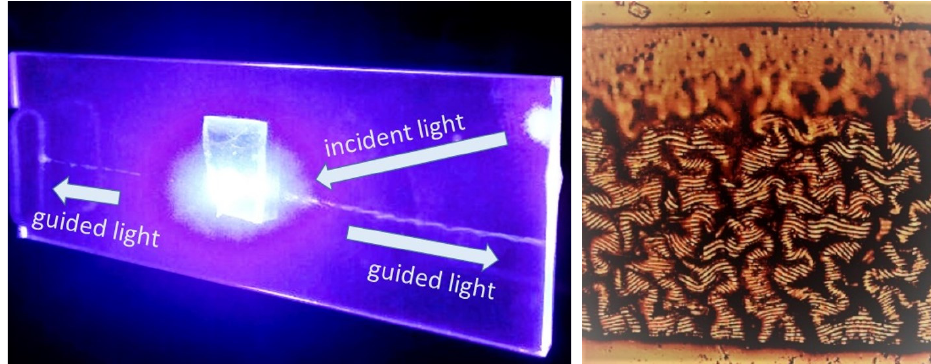
Figure 9. ( left ) 447 nm laser light guided in the 1.5 mm thick glass slide in the optical waveguide mode, due to total internal reflection of the blue light diffracted in the 350 nm diffraction grating made in the VHB 4905 elastomer sheet (attached to the glass in the center). ( right ) Optical image of the bulk diffraction grating in the VHB 4905 elastomer disturbed during the fs-laser exposure at the threshold energy of 28 nJ. The frame size is 400 µm × 400 µm.